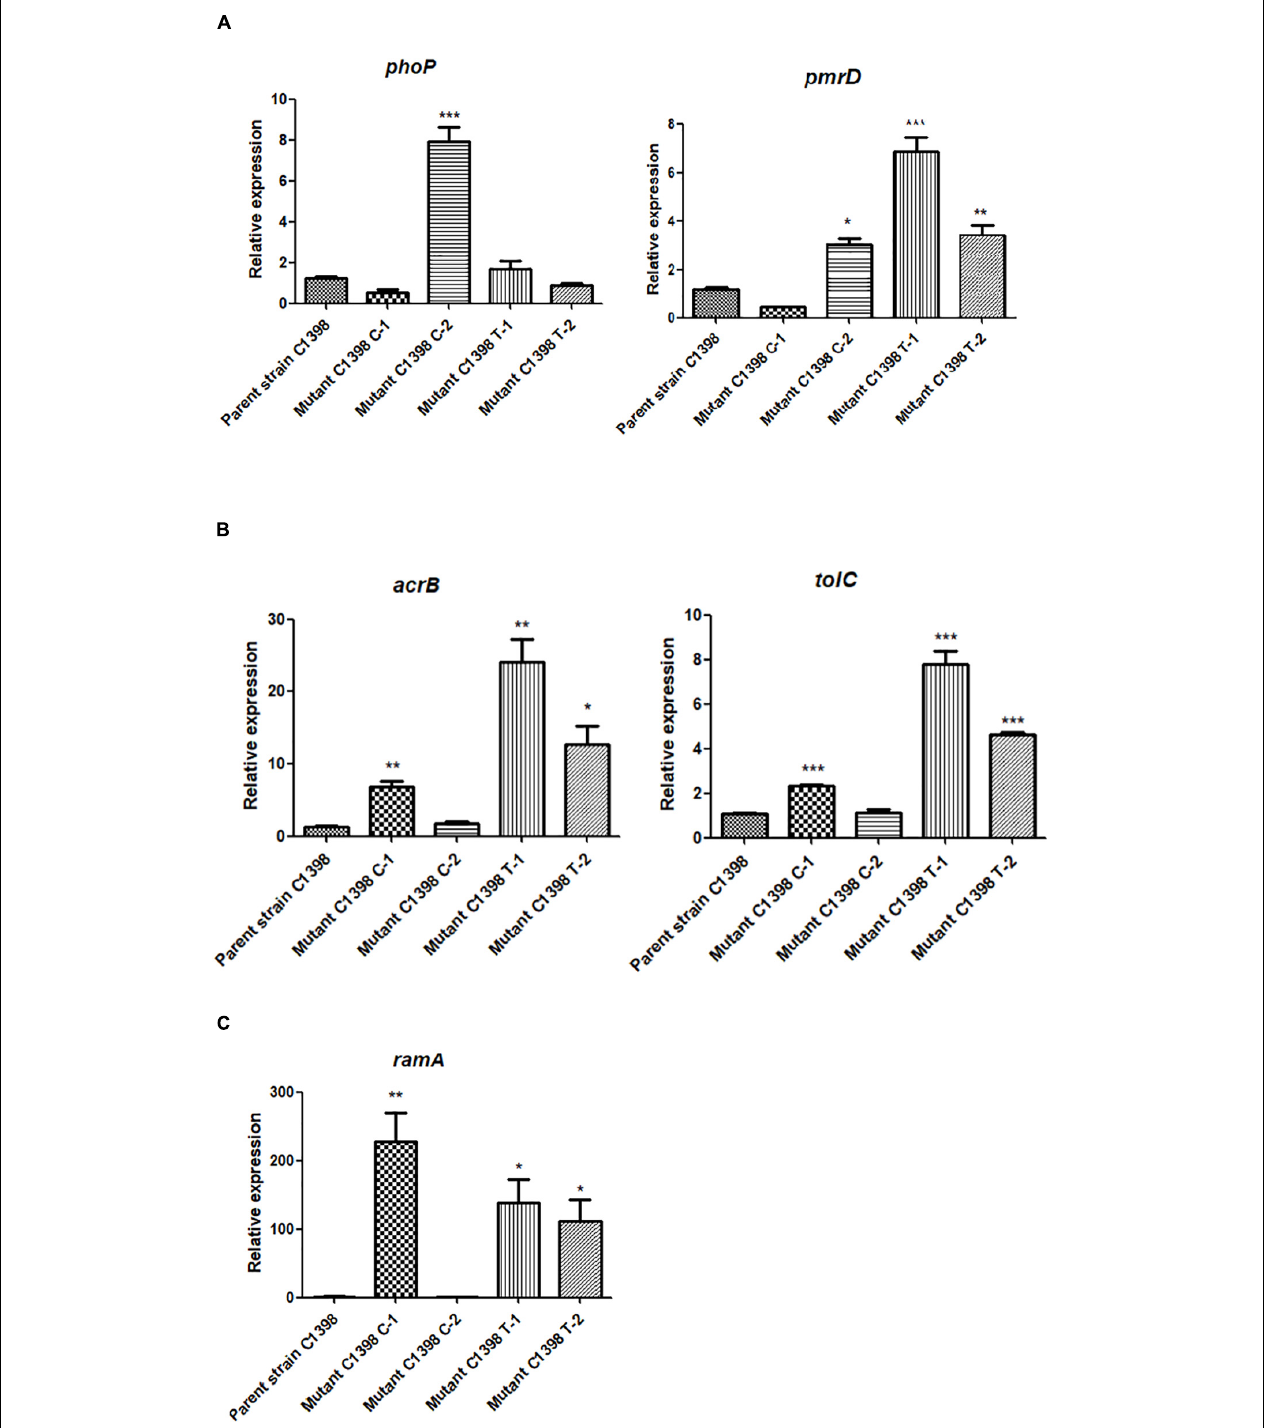
FIGURE 5 | Relative expression levels of (A) colistin resistance-associated genes ( phoP and pmrD ), (B) efflux pump genes ( acrB , tolC ), and (C) global regulon ( ramA ) in the parent CR-hvKP strain, C1398, and its corresponding mutants. In the colistin-resistant mutants selected using colistin, we noted significant differences in the expression levels of phoP ( p = 0.0005) and pmrD ( p = 0.0016) in mutant C1398 C-2 when compared with those in the parent strain, while the transcription levels of acrB ( p = 0.0037), tolC ( p = 0.0001), and ramA ( p = 0.0049) in C1398 C-1 were significantly different from those in the parental strain. In the tigecycline-selected mutants, the expression levels of pmrD ( p = 0.0007 for C1398 T-1, p = 0.049 for C1398 T-2), acrB ( p = 0.0021 for C1398 T-1, p = 0.0113 for C1398 T-2), tolC ( p = 0.0003 for C1398 T-1, P < 0.0001 for C1398 T-2), and ramA ( p = 0.0179 for C1398 T-1, p = 0.0276 for C1398 T-2) were significantly higher in the mutants when compared to the parent strain. ∗ : p < 0.05, ∗∗ : p < 0.01, ∗∗∗ : p < 0.001.